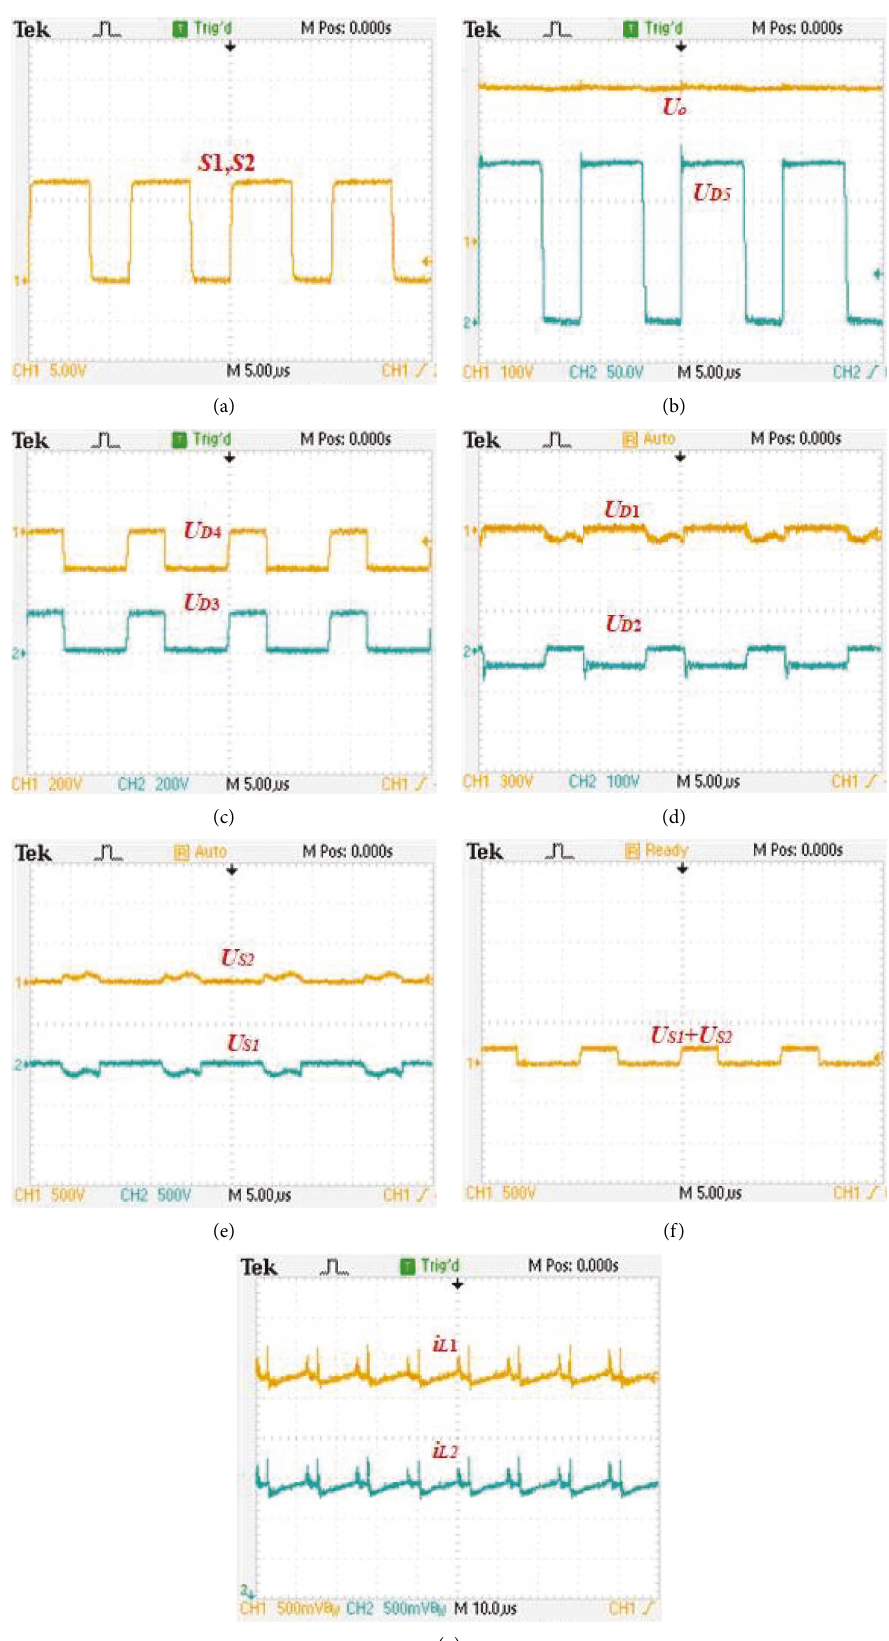
Figure 16: Experimental results when U U S 1 , (f) U S 2 + U S 1 , and (g) currents of L1 and